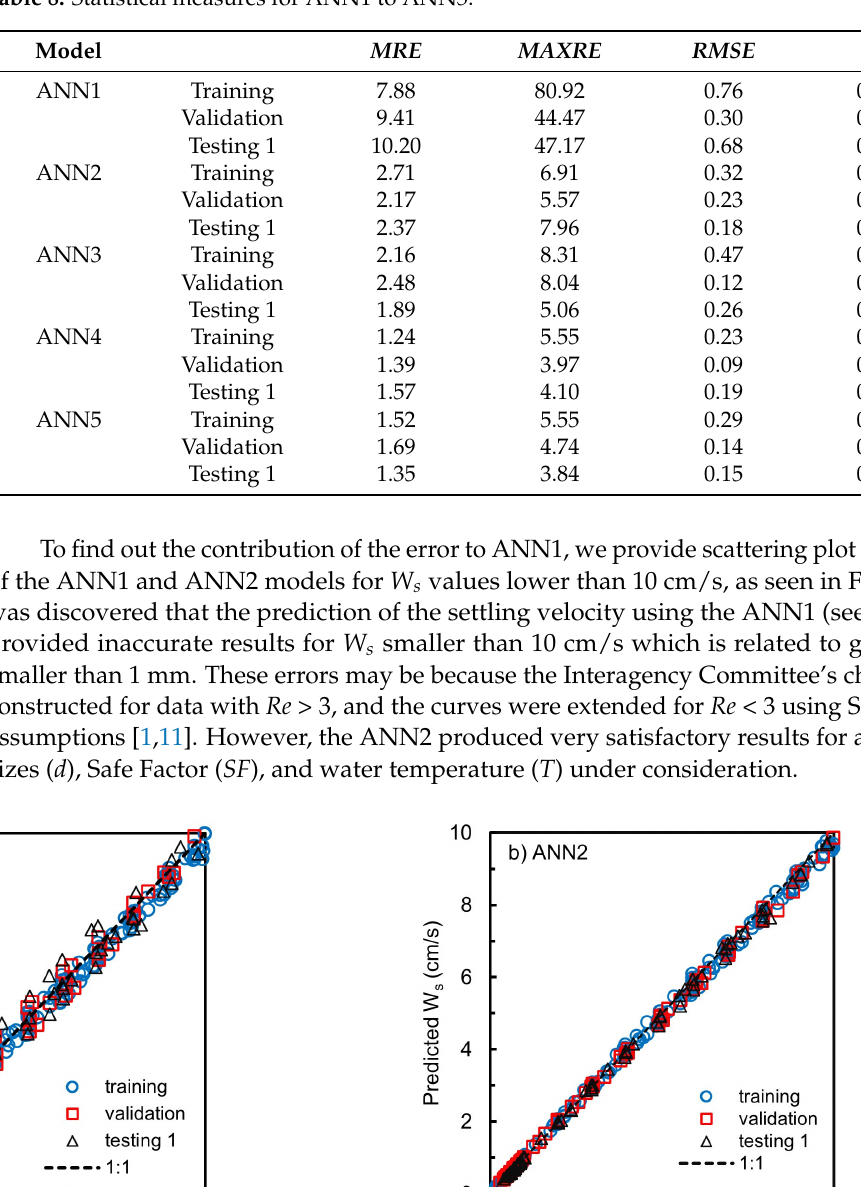
Table 8. Statistical measures for ANN1 to ANN5.